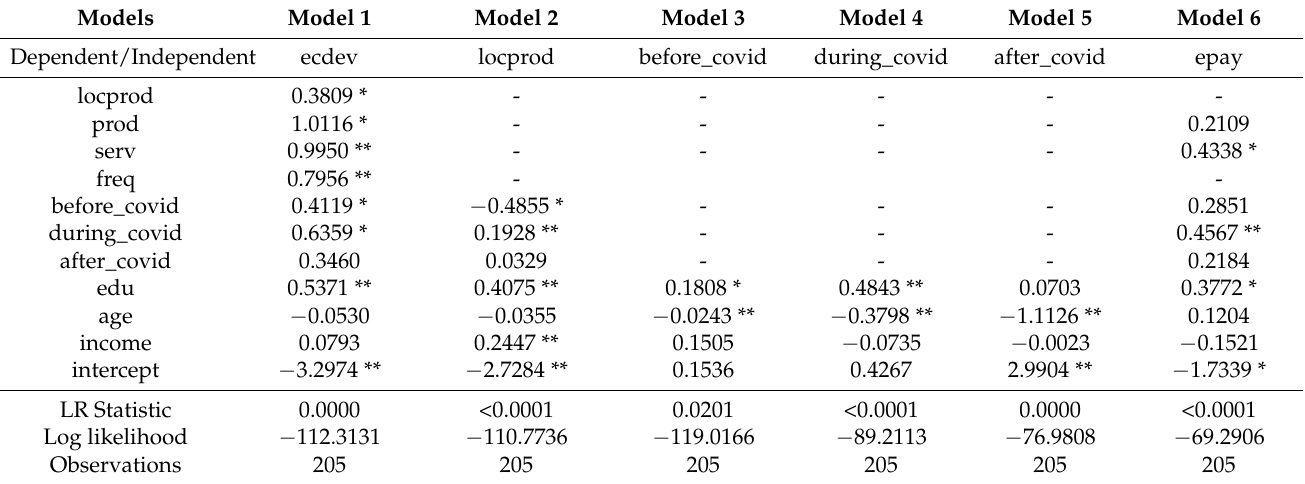
Table 2. Model results (Source: Own calculation and